Question: From the figure, is the trend upward or downward?
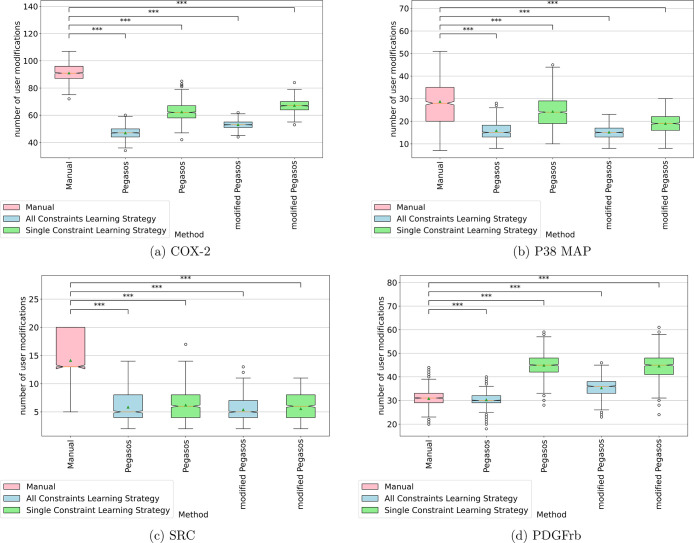
Answer: increasing